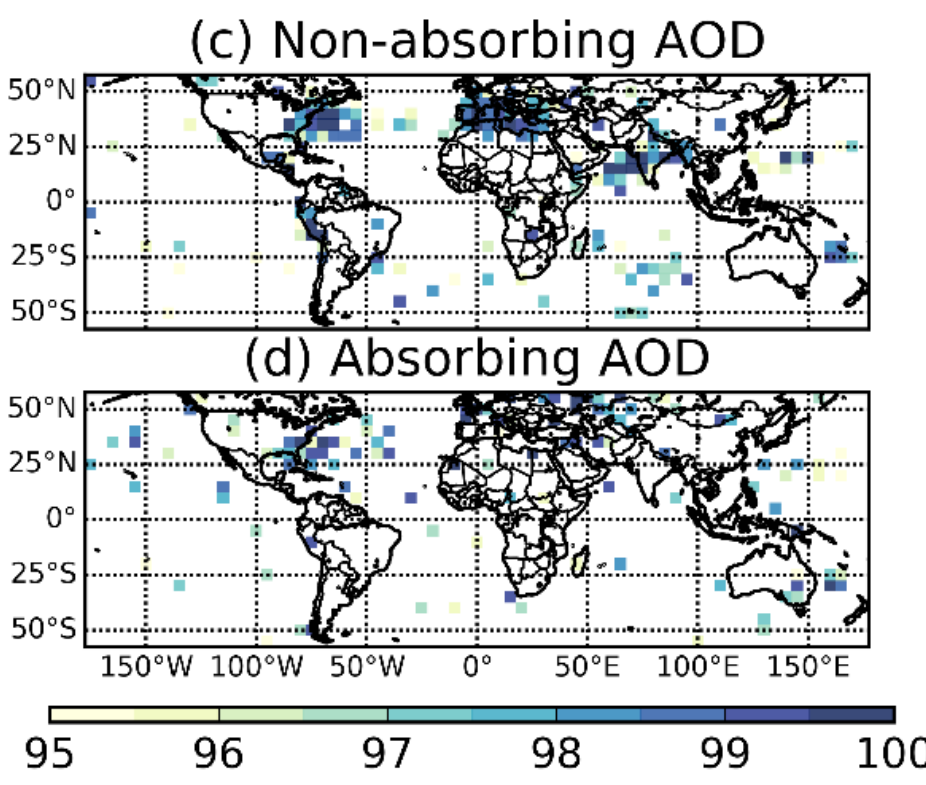
Figure A3. Confidence levels (1- p value ) in % for lag 1-year autocorrelation in the time series of annual mean ( a ) total, ( b ) nonspherical, ( c ) nonabsorbing, and ( d ) absorbing aerosol optical depths during the 17 years between March 2000 and February 2017.